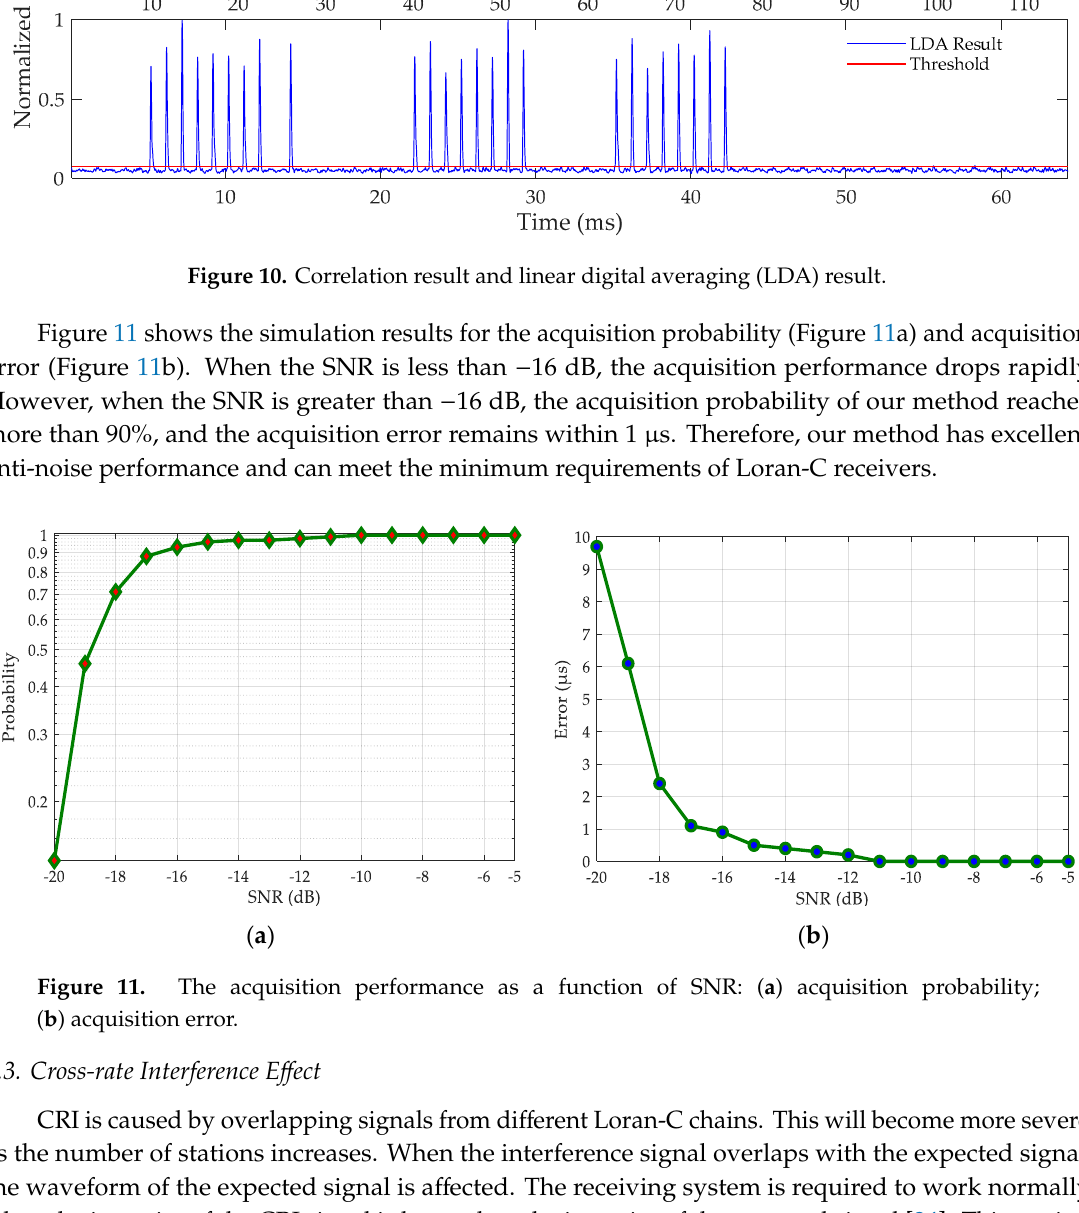
( b ) Figure 12. Effect of CRI on correlation peak amplitude and acquisition accuracy: ( a ) amplitude of correlation peak; ( b ) acquisition error.